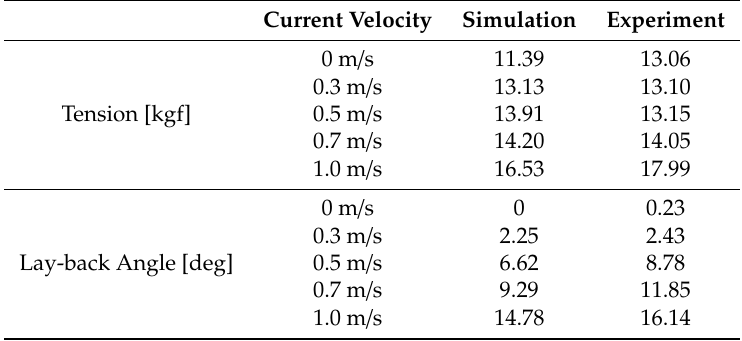
Figure 11. Experiment result of cable motion with current: ( a ) Cable lay-back angle according to current (0 m/s to 1 m/s); ( b ) Force acting on the last node of the cable. Table 3. Comparison of cable motion simulation results and experiment